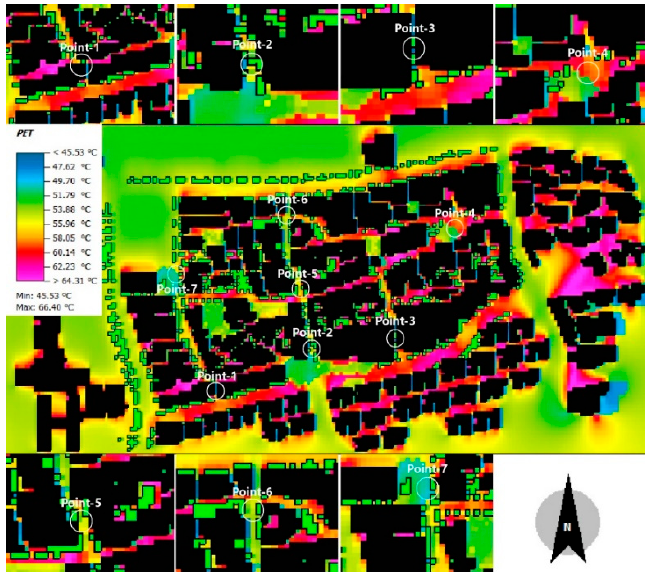
Figure 15. Spatial distribution of PET at 14:00.